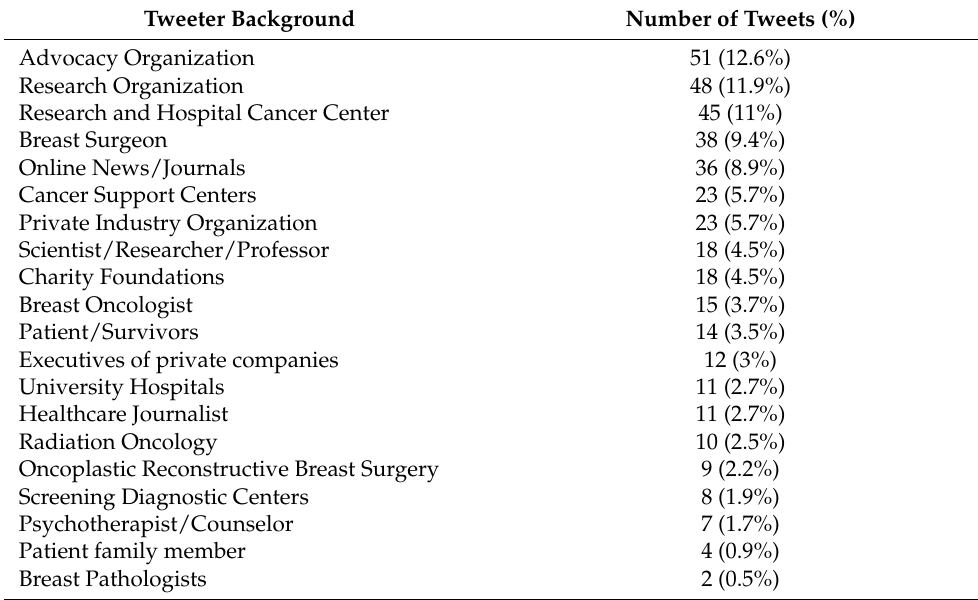
Table 1. Demographic Background of Tweeters.